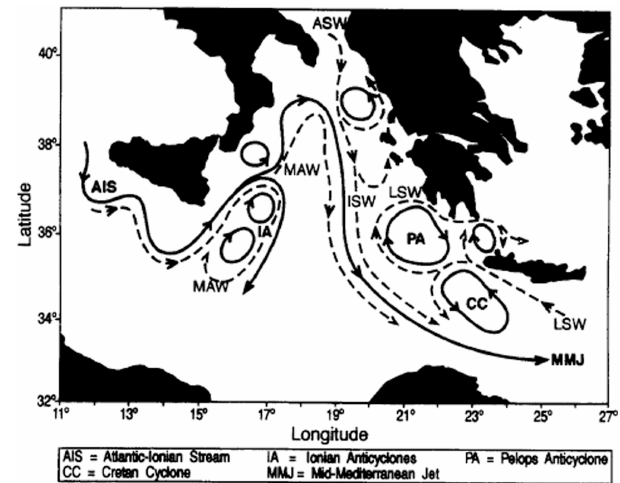
Fig. 5a. Schematic of the upper thermohaline circulation and water mass pathways in the central Mediterranean. Dashed lines mark wa- ter mass pathways. Solid lines denote permanent dynamic features, i.e., currents and sub-basin gyres, for which names are given in